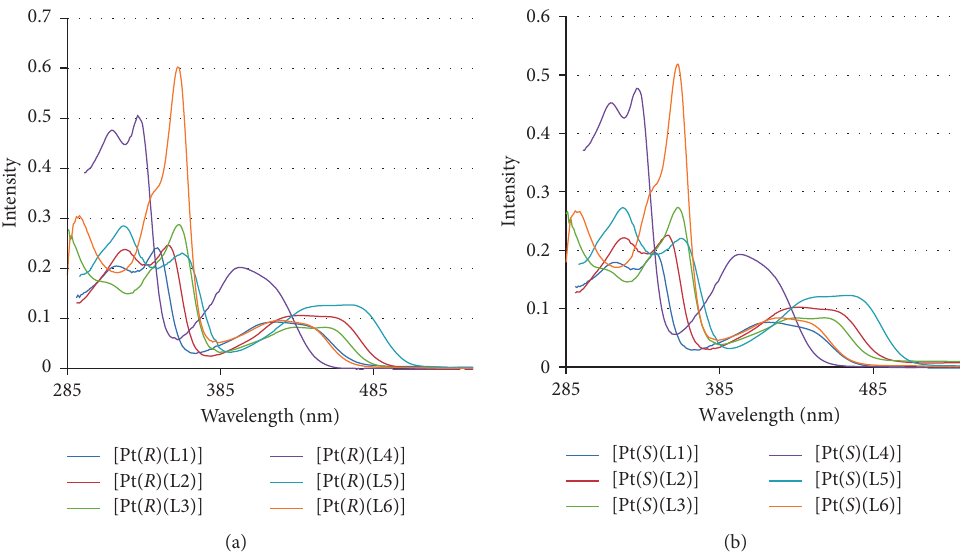
Figure 3: UV-visible spectra of chiral salen Pt(II)